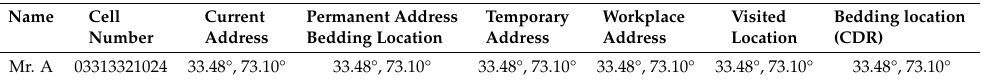
Table 4. Information gathered from the proposed